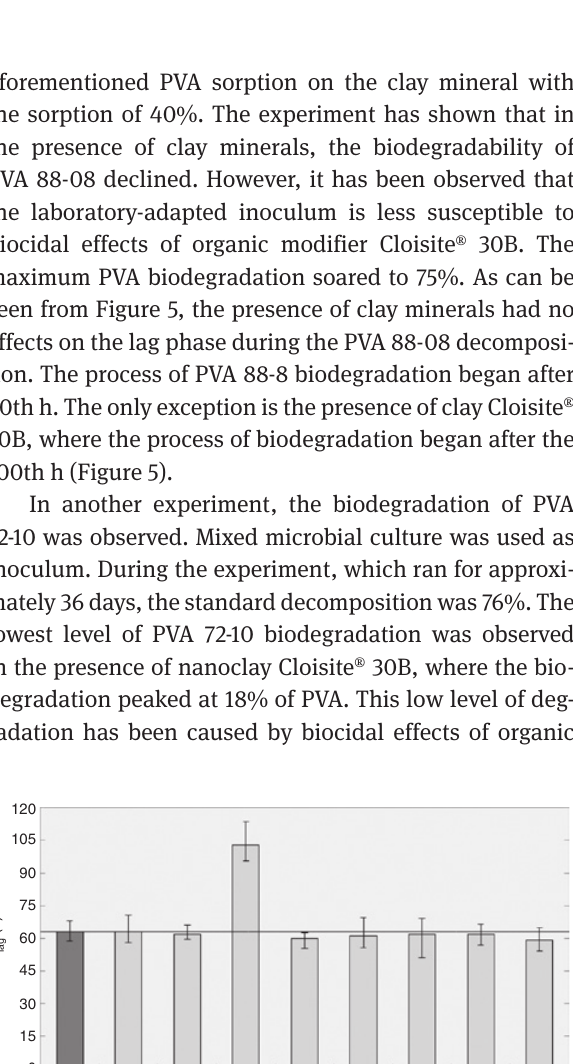
Figure 4: The lag phase during the PVA 88-8 biodegradation with no adapted inoculum in the presence of the selected group of clay minerals ( ± standard deviation).